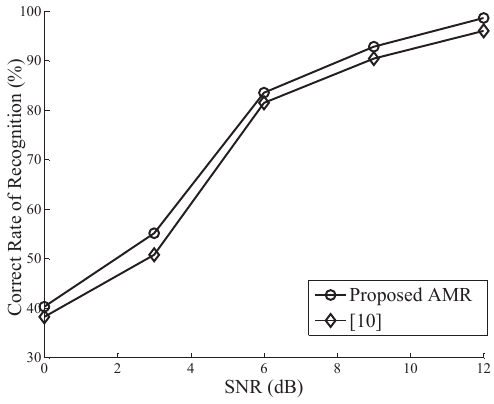
Figure 4. Performance versus SNR for Ω 2 .